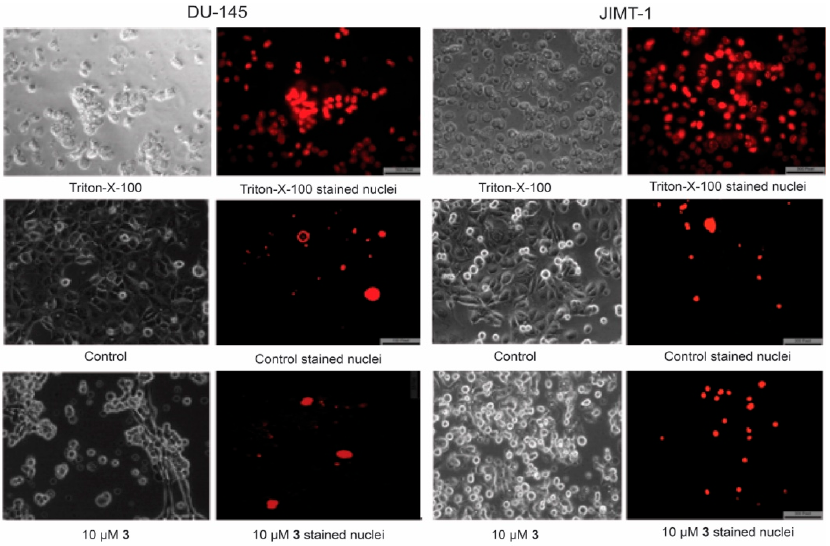
Figure 5. Evaluation of effect of compound 3 on cell membrane of DU ‐ 145 and JIMT ‐ 1 cell lines using cell impermeant ethidium homodimer ‐ 1 (EthD ‐ 1) dye that emits red fluorescence upon binding to DNA.